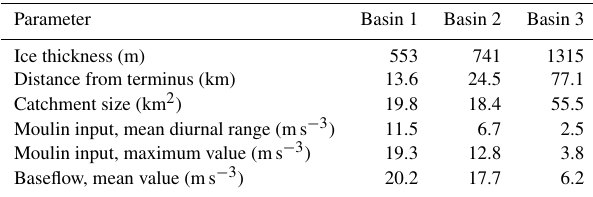
Table 2. General ice and moulin input parameters for realistic